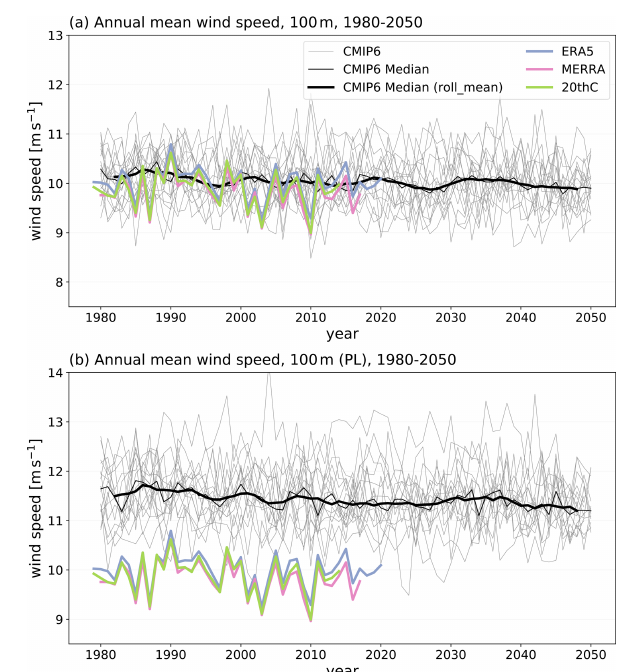
Figure 10. Annual mean wind speed at 100ma.g.l. using (a) model level winds and (b) a power law relationship (Eq. 4) averaged over the box in Fig. 1a in the CMIP6 models. Also shown are the annual mean of the three reanalyses (colours), the median of all CMIP6 models, and the 5-year rolling mean of the median.